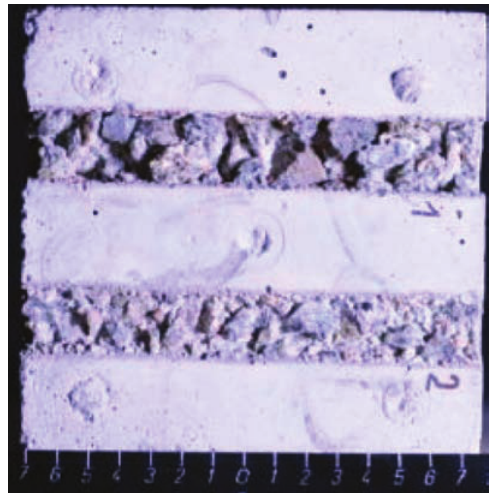
Fig. 4. An example of the trace of the wide operating fan nozzle used for concrete demolition: top kerf – one pass of pulsing jet, bottom kerf – one pass of continuous jet (both generated by identical nozzle with the identical water